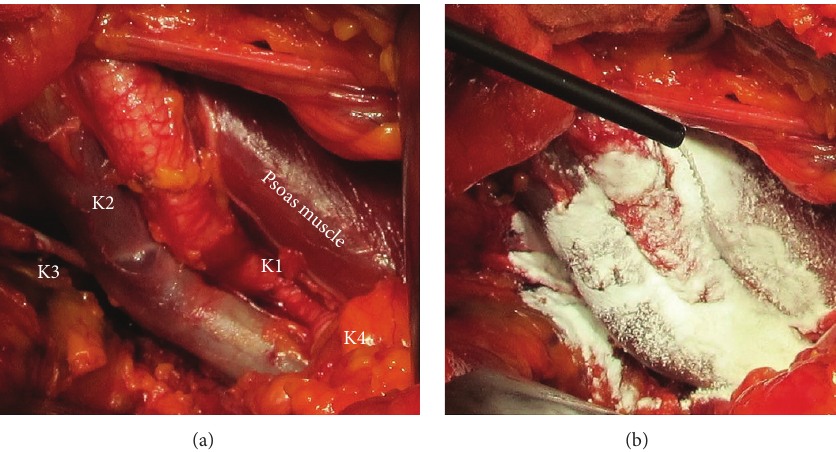
Figure 1: Site at the end of the surgical procedure after radical retropubic prostatectomy: (a) exposed iliac vessels after lymphadenectomy, (b) with polysaccharide